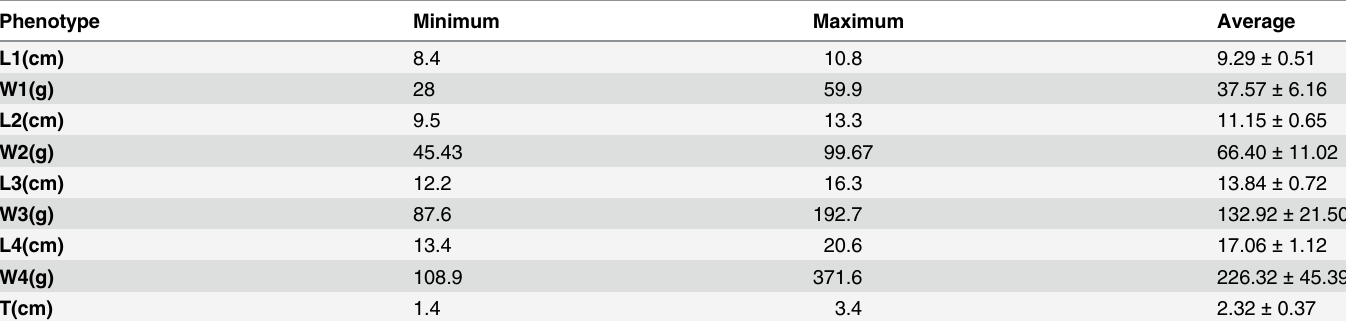
Table 5. Details of growth traits during the entire culture period.